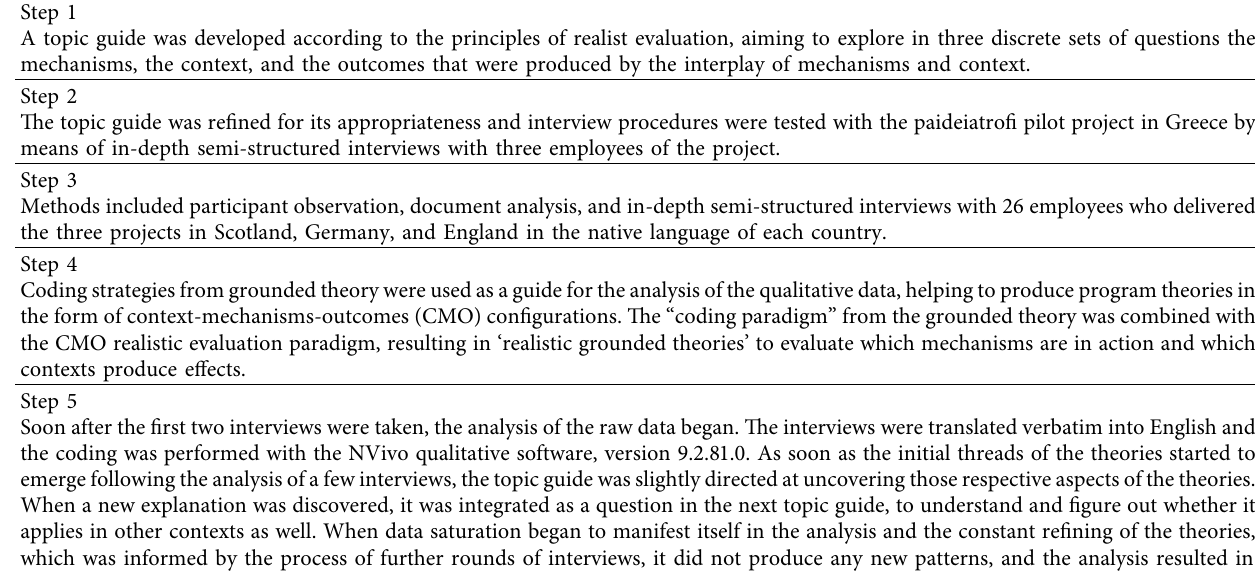
Table 1: The research